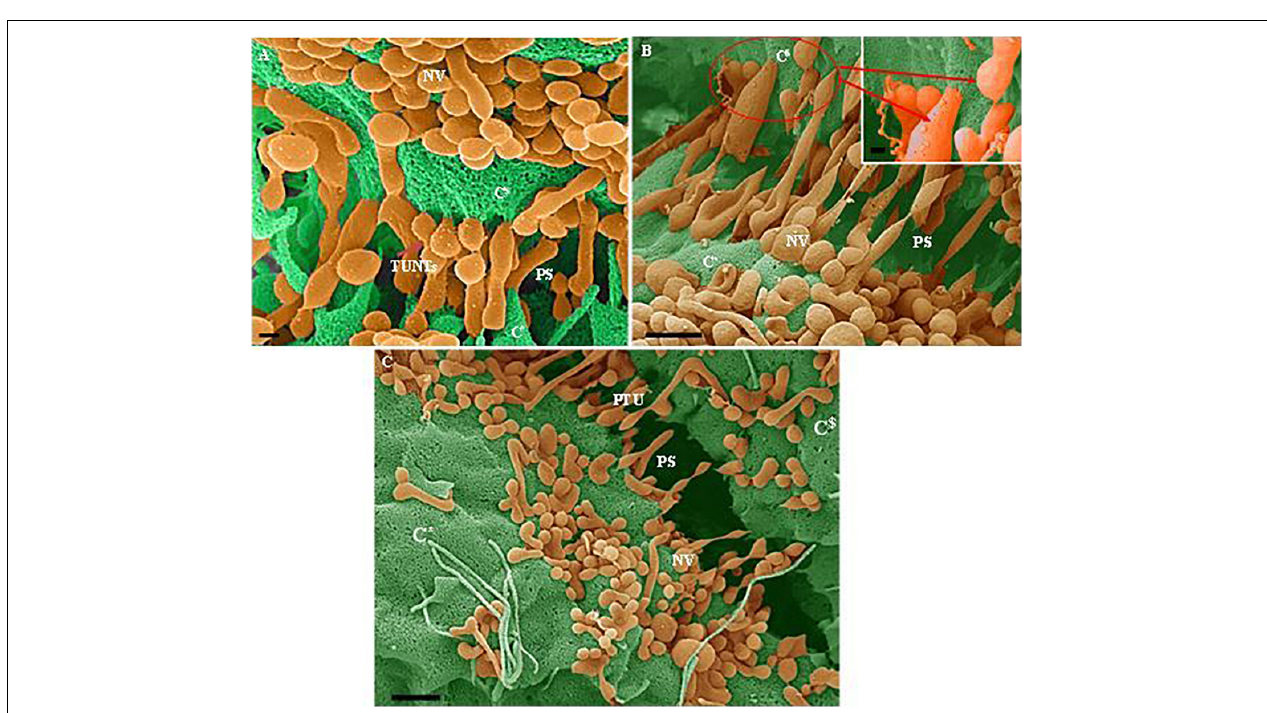
FIGURE 4 | (A–C) Indicate both the porosity and the sticky filaments of NVs found along the lateral walls lining the PC space. C* and C $ are denoted as cell 1 and cell 2, “ NV ” denotes the nanovesicle, “ PS ” denotes the PC space and “ PTU ” denotes the primordial TUNTs. (A) Scale bar = 200 nm; (B,C) Scale bar = 1,000